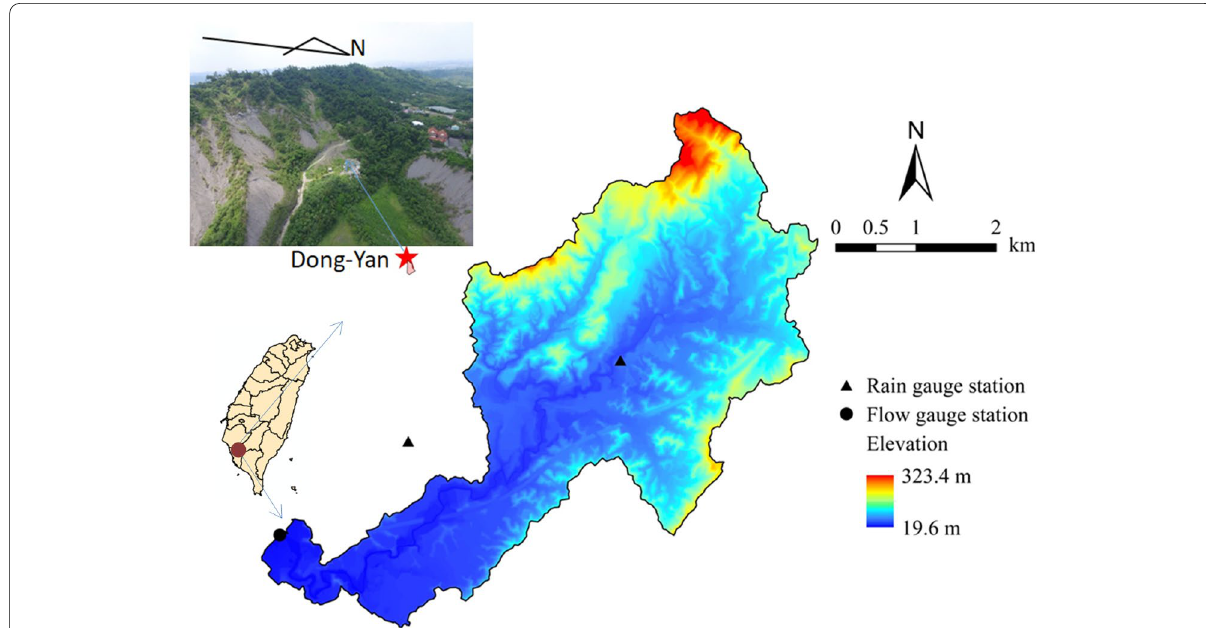
Fig. 3 Location map of Yeng‑Feng Bridge watershed and Dong‑Yen village catchment (C2)